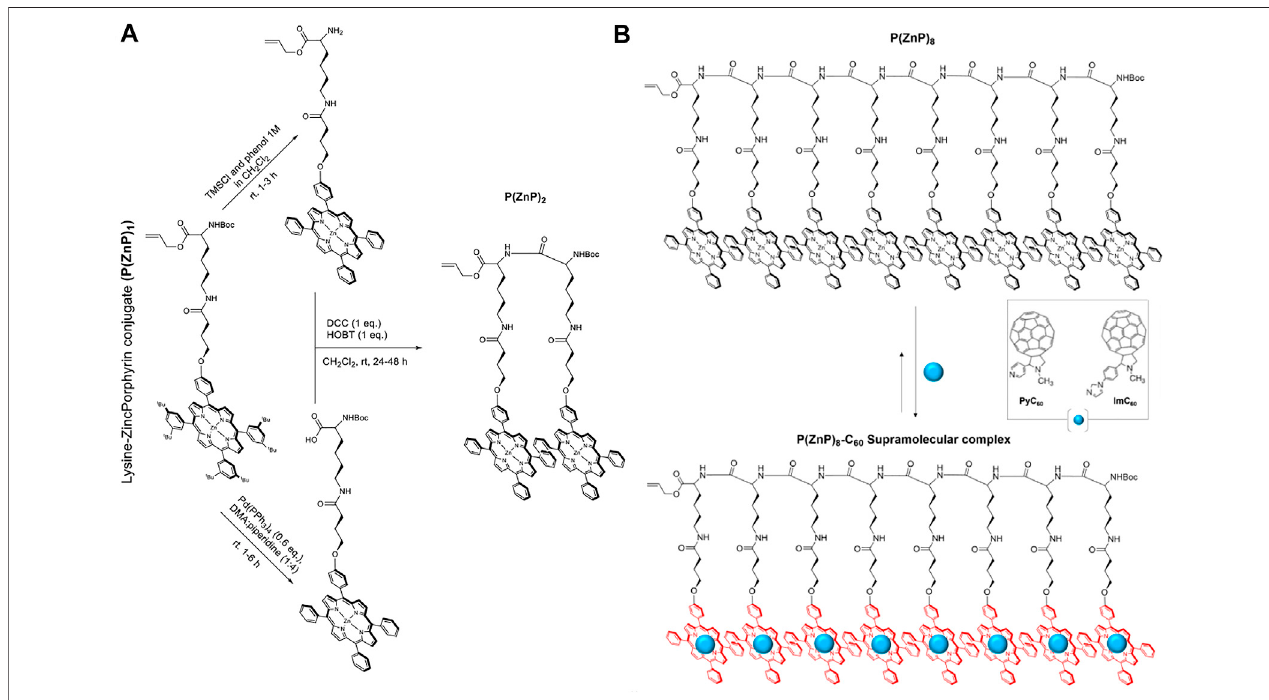
FIGURE11|(A) Generalrouteforoligomerizationof(P(ZnP) 1 )(Solladiéetal.,2000). (B) Illustration ofasupramolecularcomplexcomposed ofaporphyrin – peptide octamer P(ZnP) 8 and PyC 60 or ImC 60 (Solladié et al., 2020).